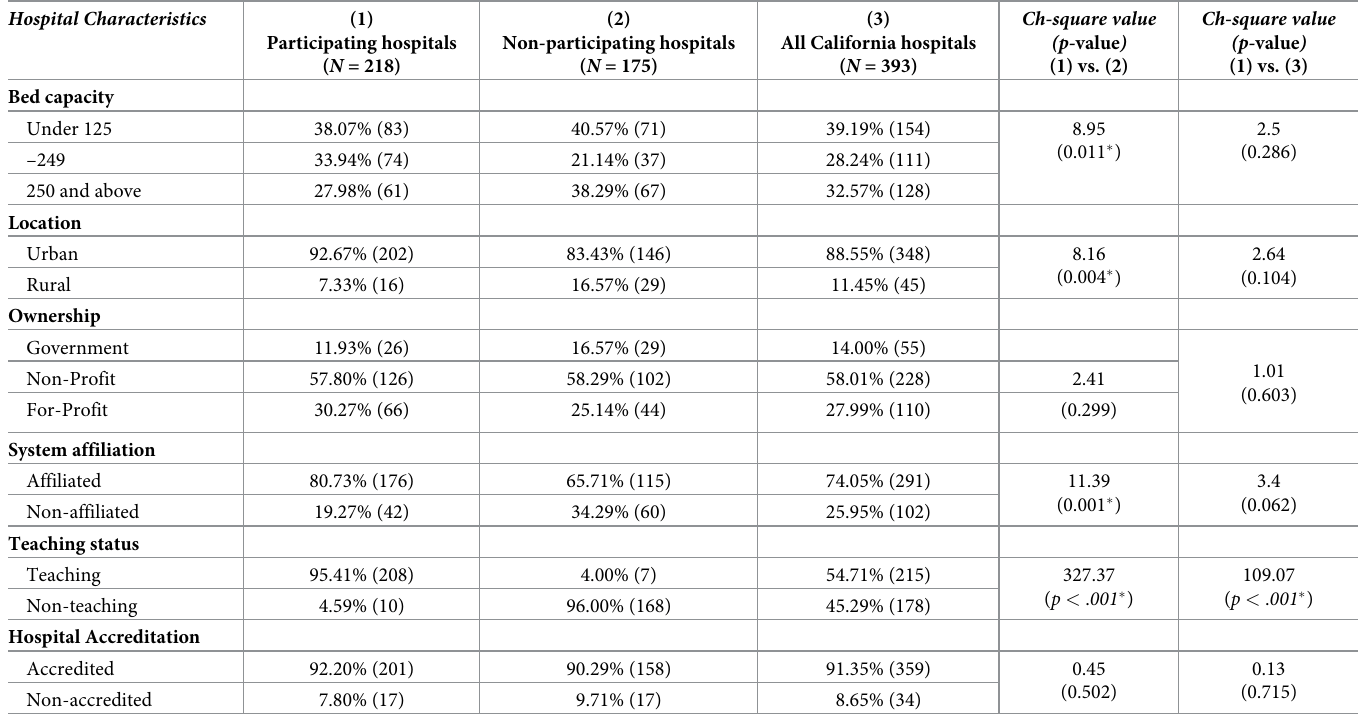
Table 2. Characteristics of participating, non-participating vs. all California